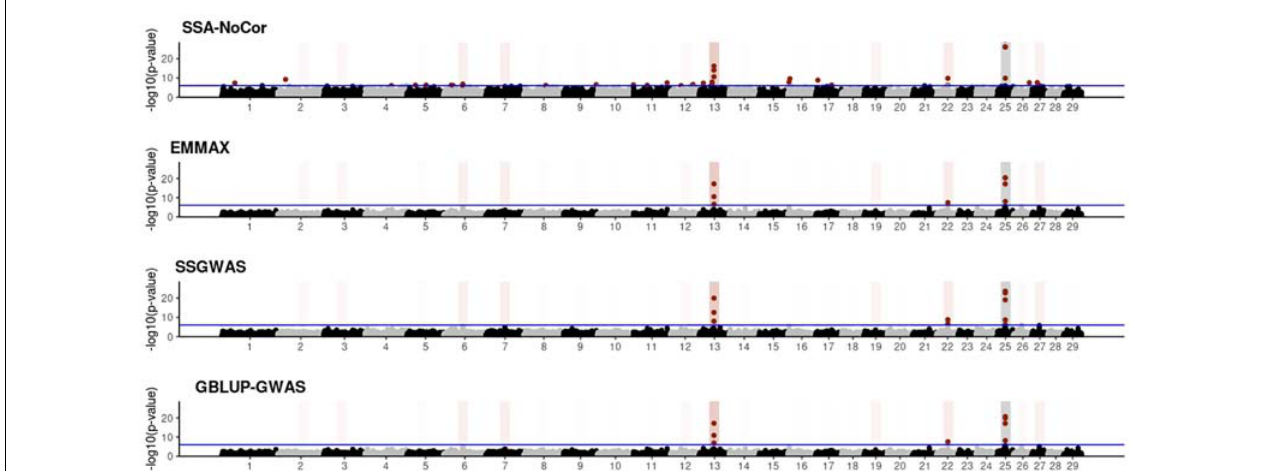
FIGURE 7 | Manhattan plots for the small population of dairy cattle when sires had an average of ten daughters. The association methods used were single-SNP analysis without correction for population structure (SSA-NoCor), efficient mixed-model association expedited (EMMAX), single-step GWAS (ssGWAS), and genomic best linear unbiased prediction GWAS (GBLUP-GWAS). Significant SNPs are indicated in red, whereas vertical bars indicate the position of the simulated quantitative trait nucleotide (QTN). The darker the vertical bar, the stronger QTN effect. The blue horizontal line corresponds to the rejection threshold based on a significance level of 0.05 with a Bonferroni correction for multiple testing.